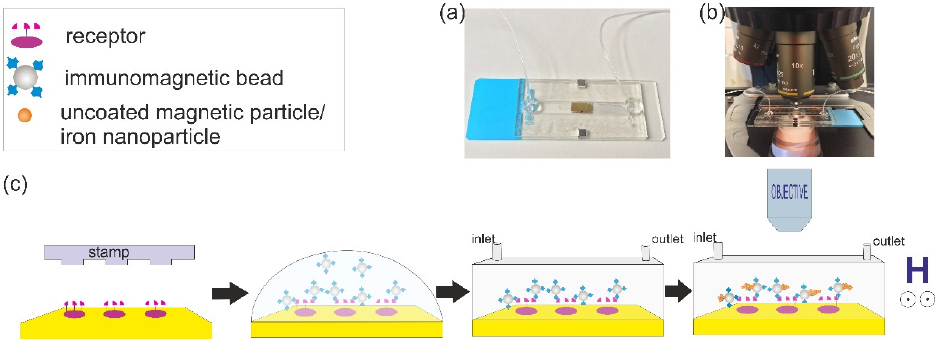
Figure 1. Schematic of the first set of experiments: iron nano particle accumulation around immobilized base beads. ( a ) Picture of the microfluidic chamber including gold chip inside and permanent magnets; ( b ) Picture of the measurement setup; ( c ) Illustration of the immobilization of immunomagnetic beads on gold chip and accumulation of iron nano particles.